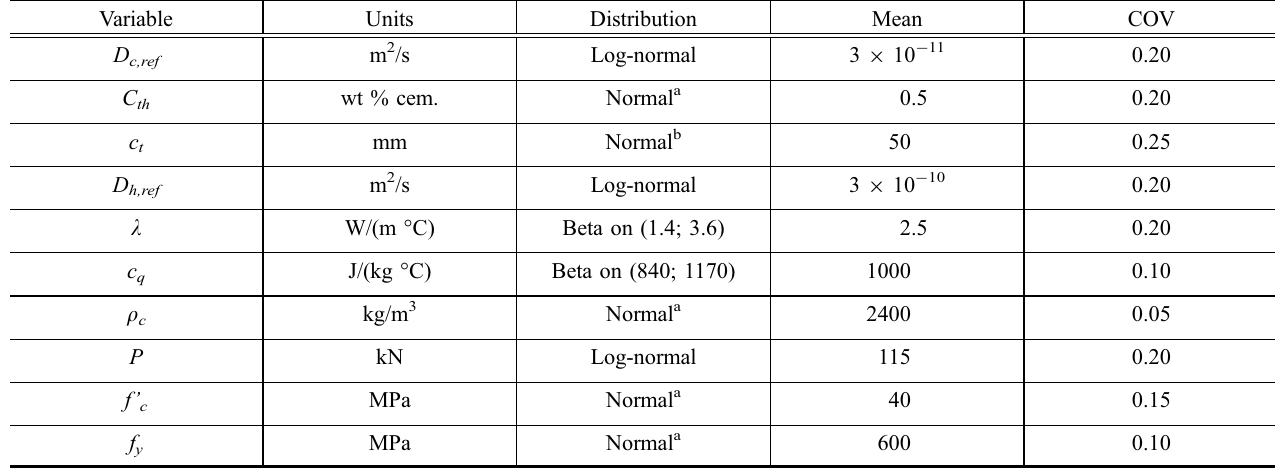
Table 6 Probabilistic models of the random variables (Bastidas-Arteaga et al.